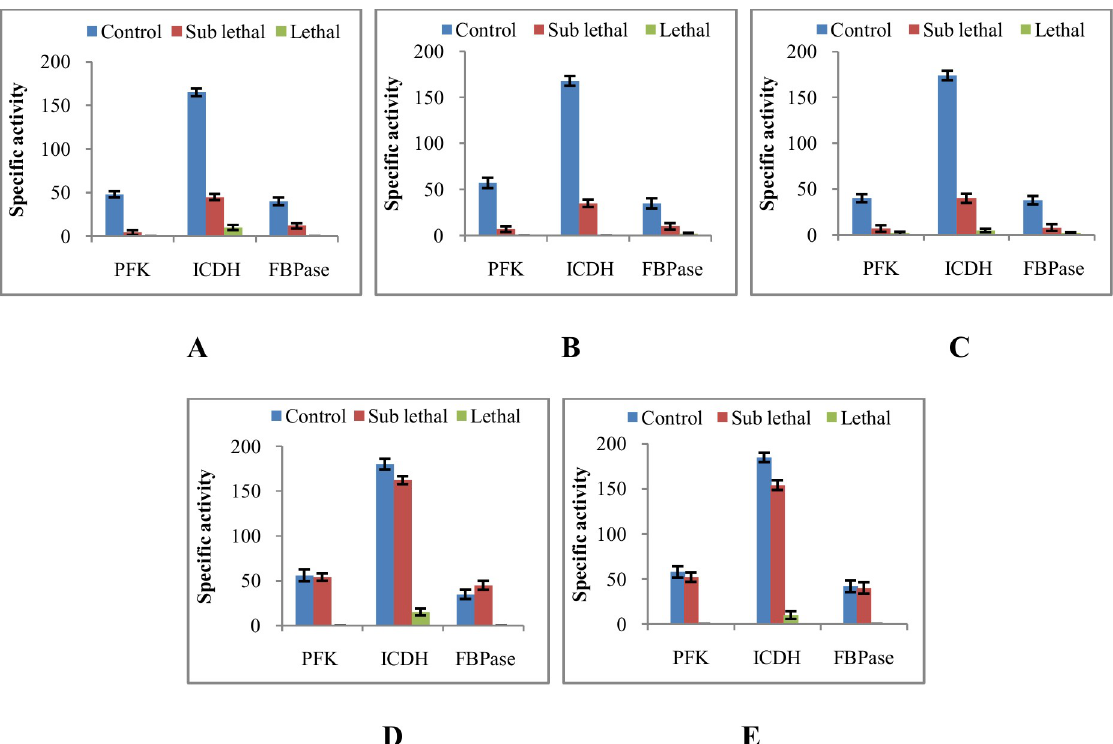
Fig 6. Profile of central carbohydrate metabolic enzymes in pathogenic bacteria upon treatment with ethyl acetate extract of AE1: A- B . subtilis ; B- L . monocytogenes ; C- S . aureus ; D- E . coli ; E- S . typhimurium